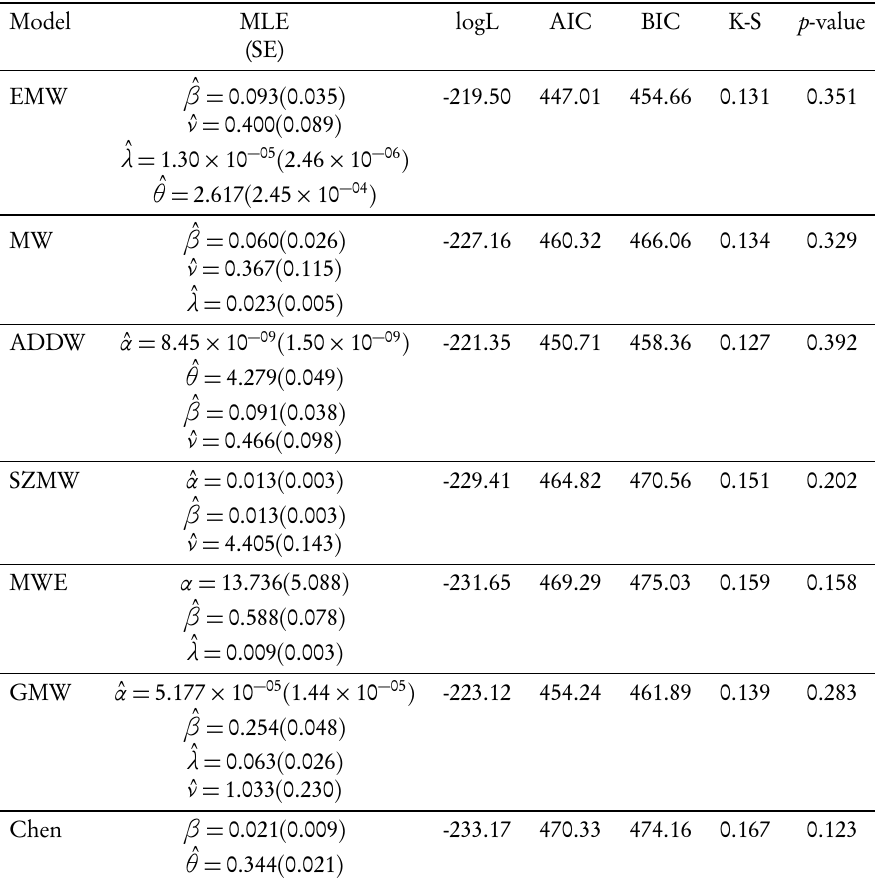
Fitting summary for the Aarset data